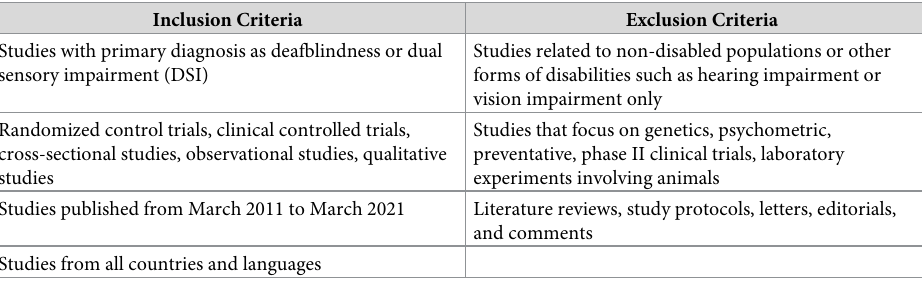
Table 1. Inclusion and exclusion